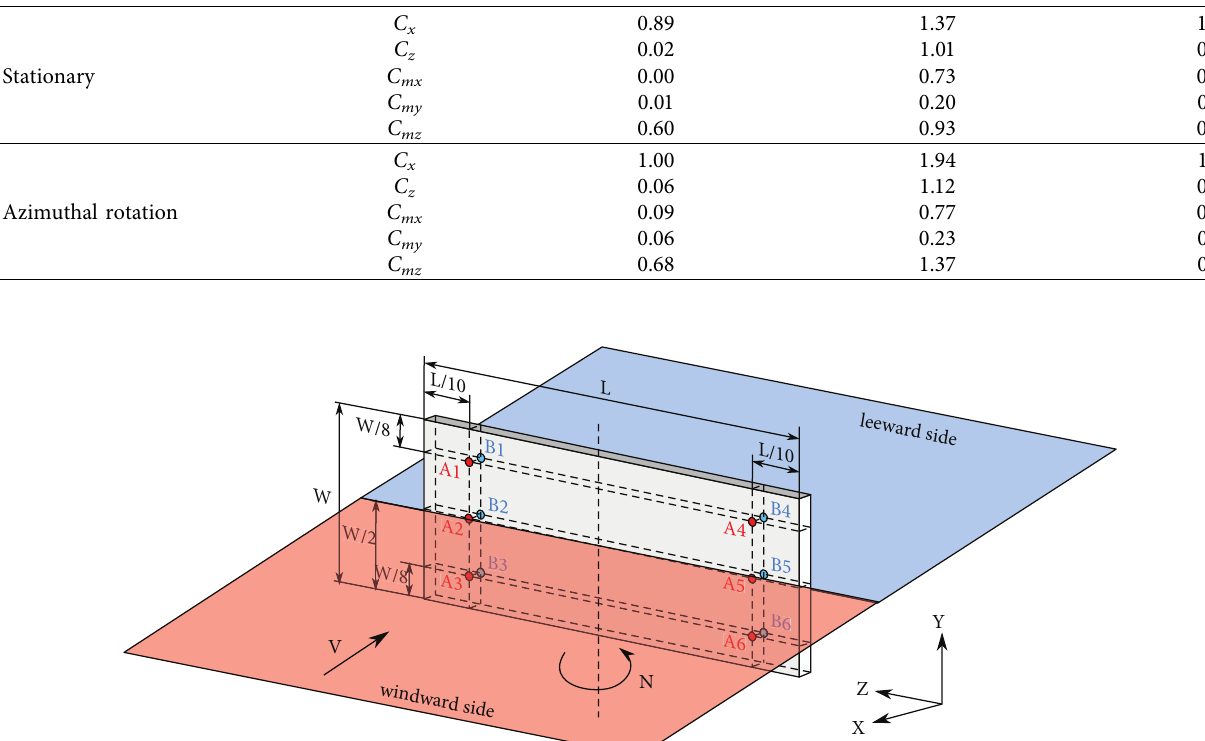
Table 3: The mean, maximum, and RMS values of aerodynamic coefficients for the solid plate antenna when the antenna is stationary and azimuthal rotation (the direction is not included in these results). Solid plate